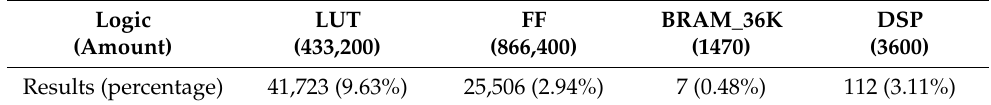
Table 1. Vivado synthesis results of the